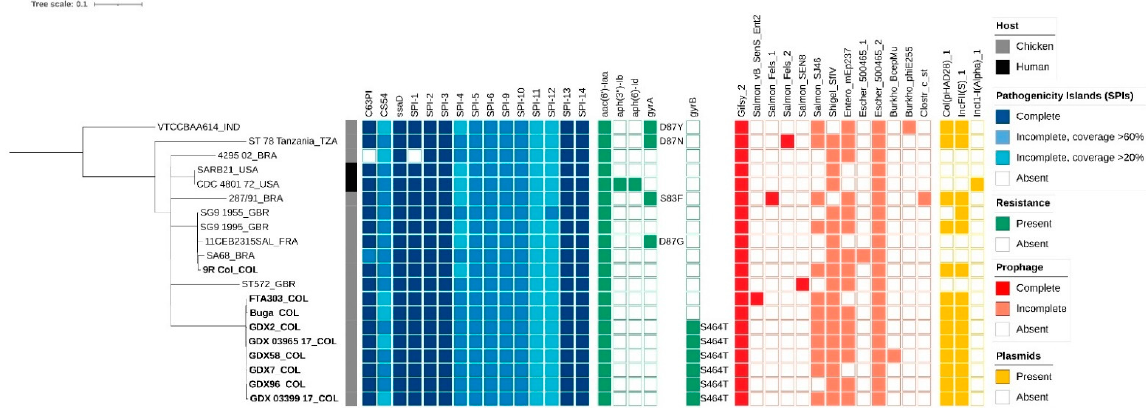
Figure 2. Genomic features of the studied S. Gallinarum strains. From left to right: phylogenetic tree, host, Salmonella pathogenicity islands, resistance genes, prophages, and plasmids.